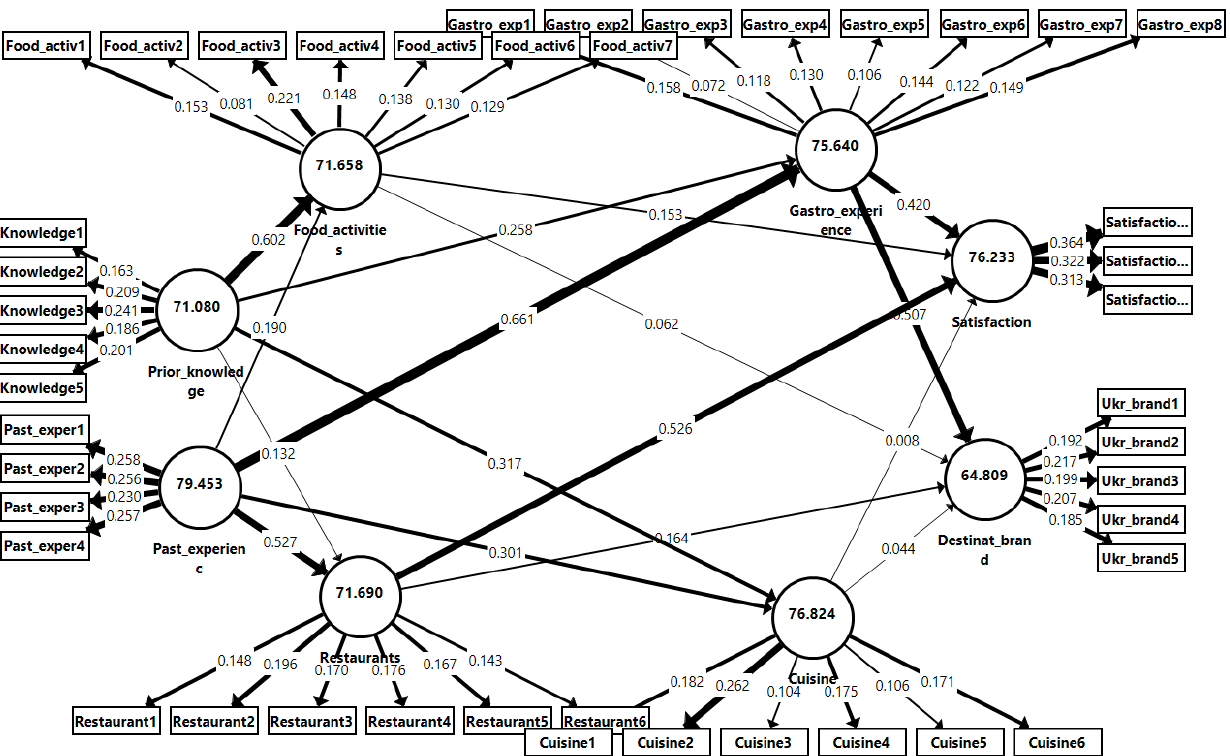
Figure 2. Structural model using IPMA.